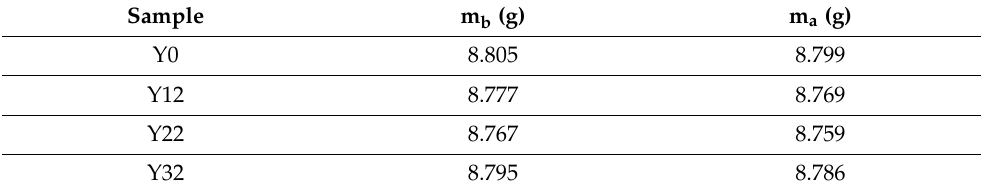
Table 6. Sample mass before and after